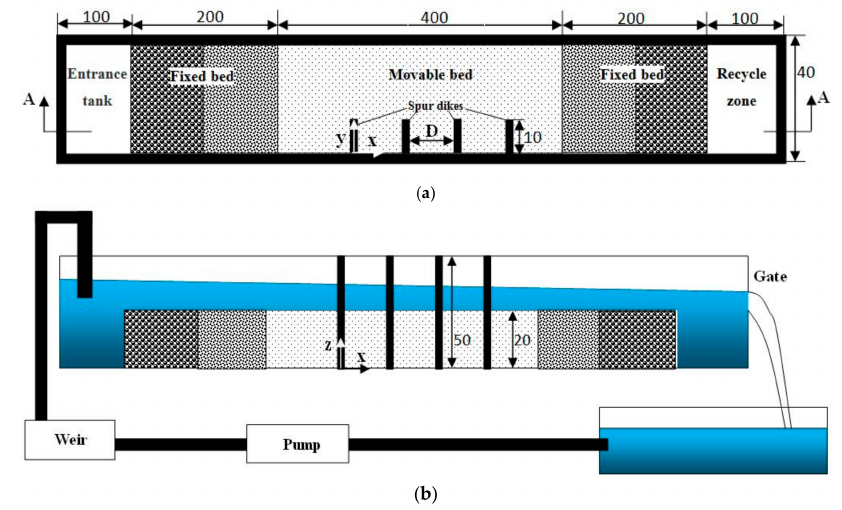
Figure 1. Experimental setup ( a ) plan view; ( b ) A-A sectional view (units: cm).